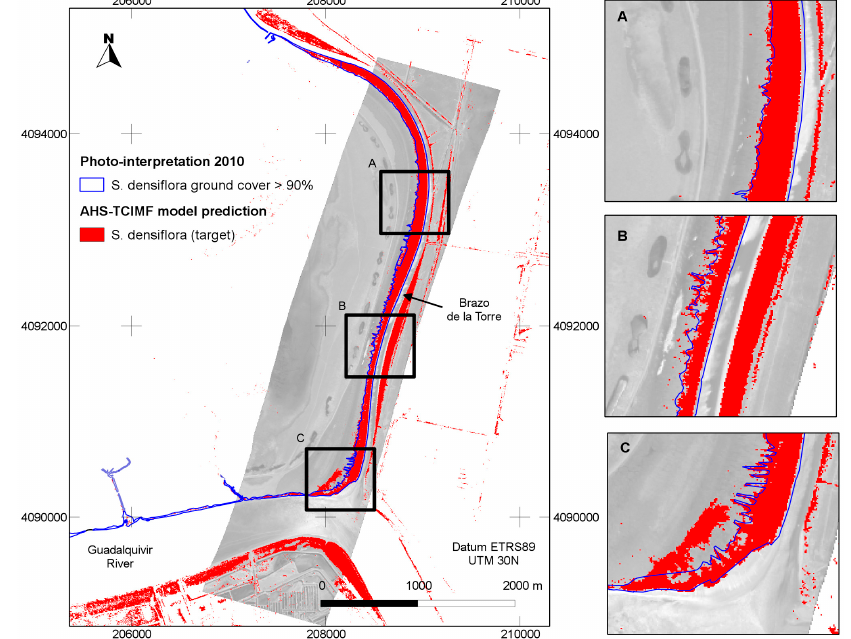
Figure 6. Qualitative validation of best model prediction using a previous photo-interpretation of Spartina densiflora (blue line) on top of model prediction (in red). Model prediction according to the Target-Constrained Interference-Minimized Filter (TCIMF) algorithm on the AHS sensor image (one of the best models according to AUC). The gray background represents the area of overlap of the CASI and AHS images. Polygons overlaid in blue represent the limits of a photo-interpreted coverage of S. densiflora on the right bank of the “Brazo de la Torre” and Guadalquivir River using summer 2010 aerial photos. ( A – C ) show details of the agreement in the limits of both data sets. ( C ) shows a clear disagreement that can be either an error of photo-interpretation or an error of the model. Note that the left bank, when S. densiflora is also present, was not photo-interpreted.